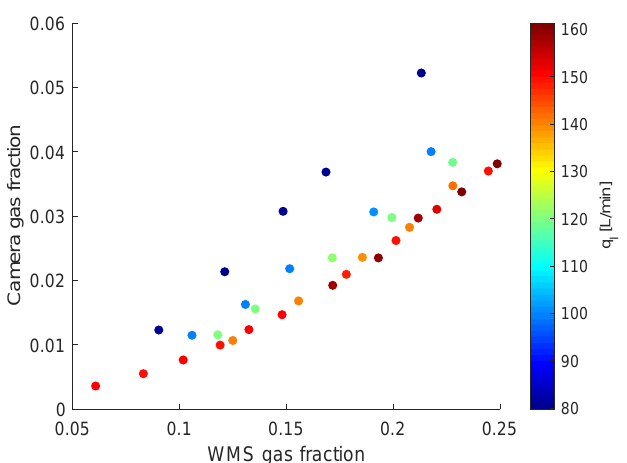
Figure 16. Average volume fraction of the gas core downstream of the swirl element (camera gas fraction) as a function of the average gas volume fraction upstream of the swirl element (WMS gas fraction) and the liquid flow rate ( q l